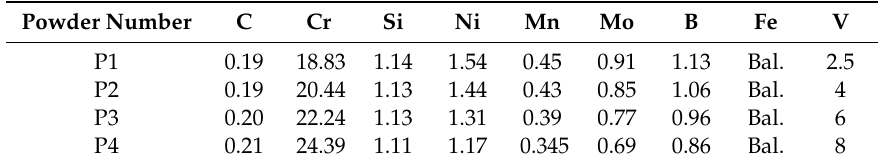
Table 2. Composition designing of alloy powders for di ff erent Cr 3 C 2 and FeV50 content (wt. %).